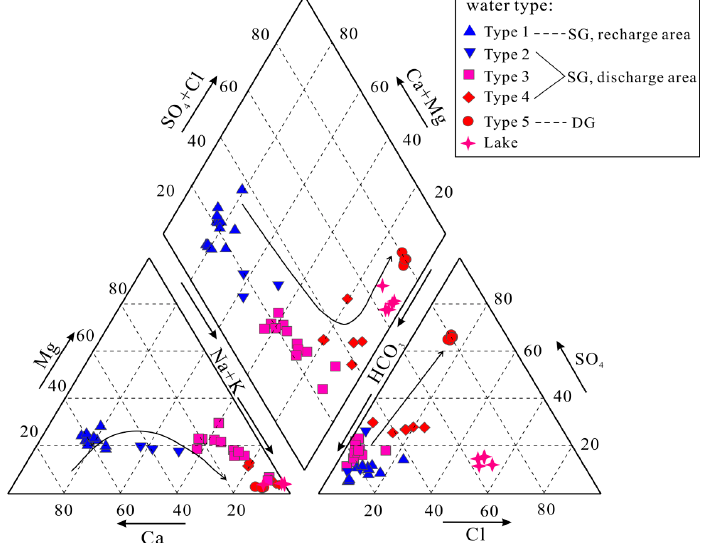
Figure 3. A Piper Plot illustrating the major ion chemistry of groundwater and lake water: The groundwater samples are divided into five geochemically distinct types: type 1 (Ca(Mg)–HCO 3 ), type 2 (mixed cations-HCO 3 ), type 3 (Na–HCO 3 ), type 4 (Na–HCO 3 (SO 4 )) and type 5 (Na–SO 4 ). The black solid lines in the diagrams are the groundwater chemical evolutionary trend. SG and DG in the legend represent shallow and deep groundwater, respectively.